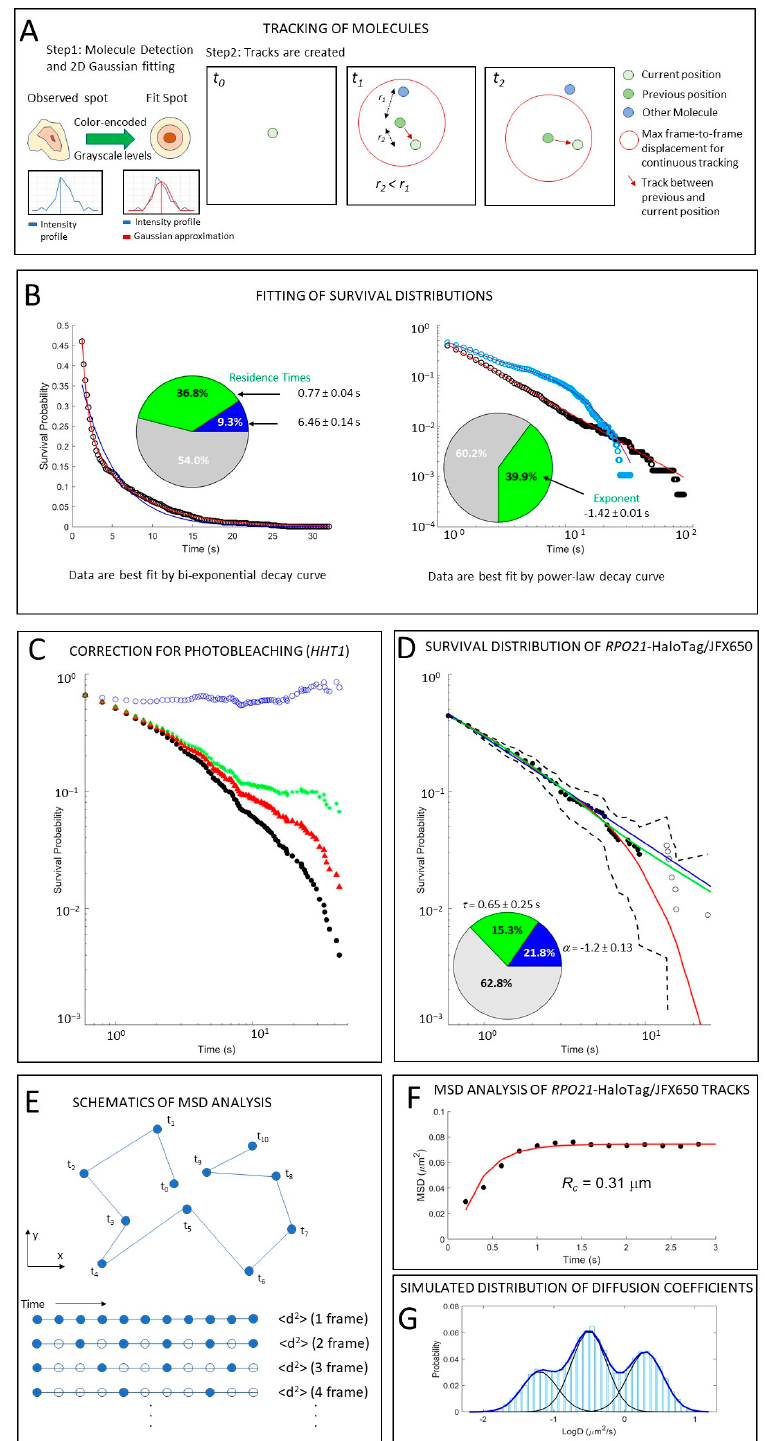
Figure 2. How to analyze the data? ( A ) Schematics of tracking single molecules. Step 1 (left): Detection of the fluorescent spot location by a Gaussian approximation of the real single molecule spot brightness distribution. Step 2 (right): Connecting two sequential positions of the same molecule in the movie (right). To link sequential positions of the same molecule observed in t 0 and t 1, the shortest distance from the molecule’s position in t 0 is selected. ( B ) Schematics of survival distribution analysis from simulated data. Left: Survival distribution (circles) approximated by a mono-exponential (blue line), or bi-exponential (red line) decay curve, and pie chart for estimated distributions of the diffusing sub-fraction (gray), short-binding events (green), and long-binding events (blue). Fitting with a bi-exponential decay